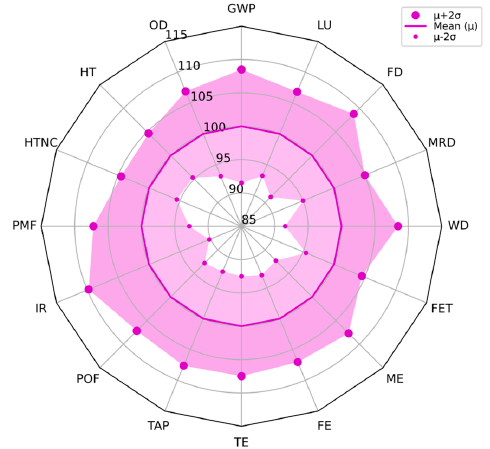
Figure 9. Results of normalized uncertainties over the life cycle of an inverter operating point for a 150 kW load from a DC power source of 450 V, based on 15 years and 10,000 operating hours. Use of a semi-quantitative approach focusing solely on input streams and a Monte Carlo setup with 1000 iterations. The associated abbreviations are presented in Table